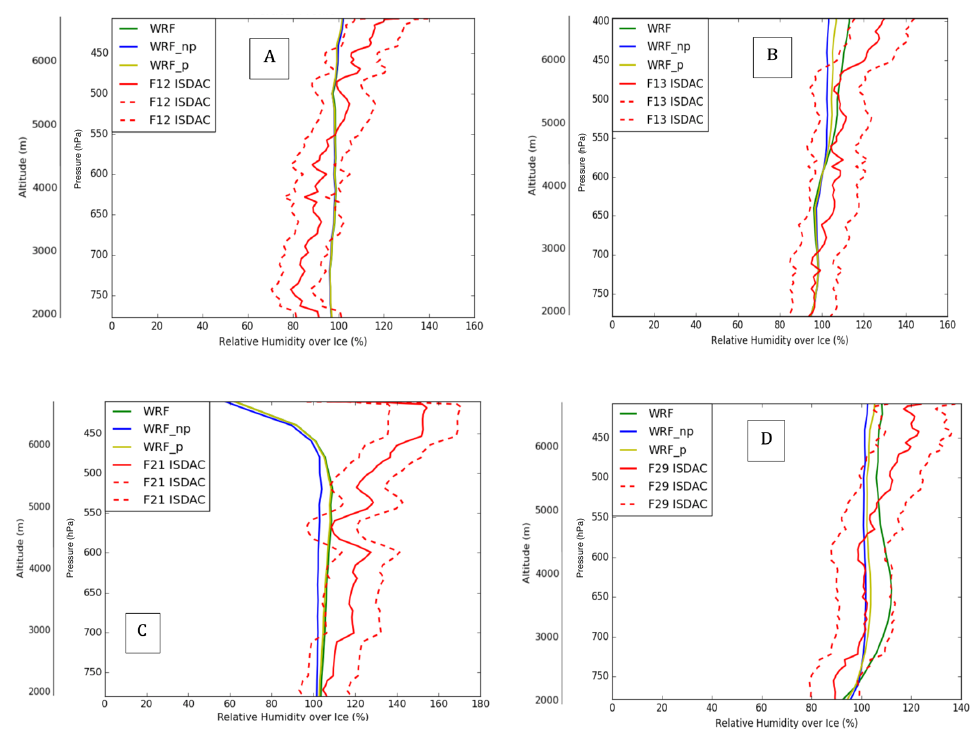
Figure 4. Comparison of the observed and simulated (WRF, WRF_np and WRF_p) vertical relative humidity with respect to ice (RHi) for the flights F12 ( A ), F13 ( B ), F21 ( C ) and F29 ( D ). The red solid and dashed lines represent the vertical profiles of the mean and standard deviation of